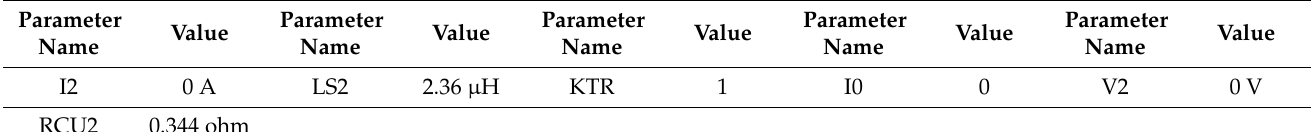
Table A8. Electrical parameters of the transformer, secondary side—TFR2P2_n from Figure